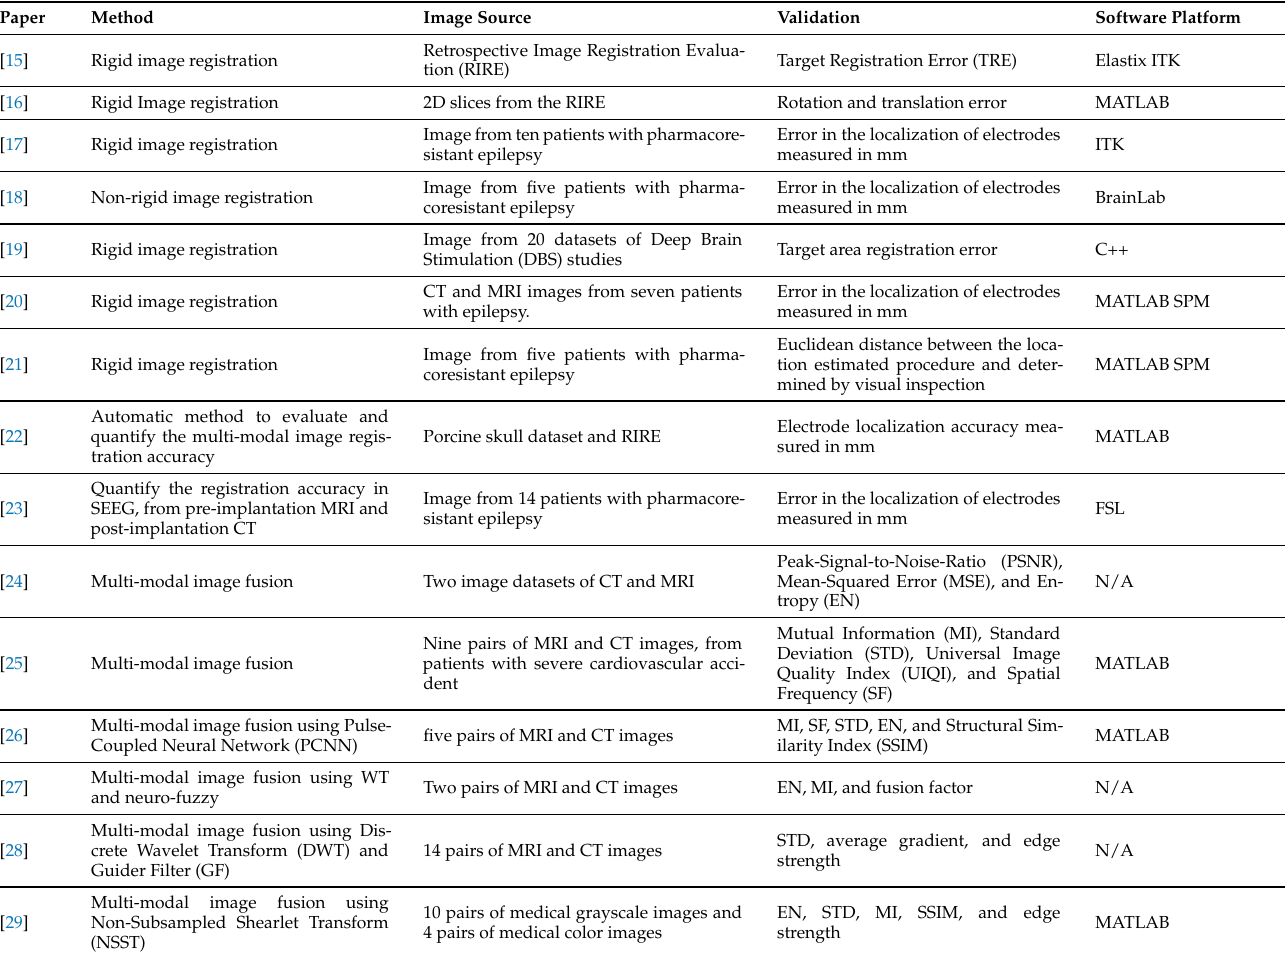
Table 2. The fifteen original research articles